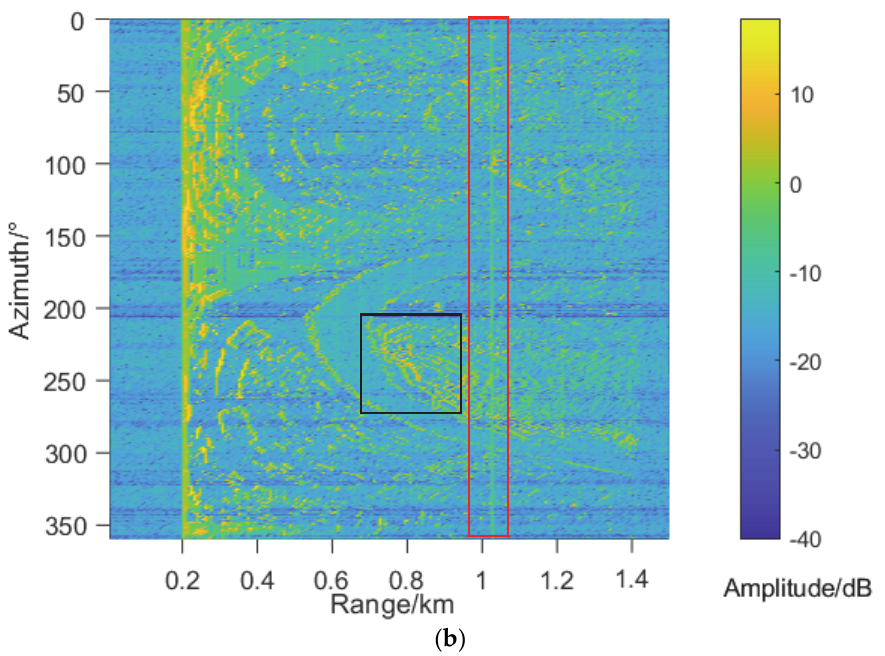
Figure 6. The comparison of range profiles at different azimuth angles between 3D PE in ( a ) and 2D PE model in ( b ) under the same conditions as the above and radar erection heights is 500 m. The target is marked by a red box.